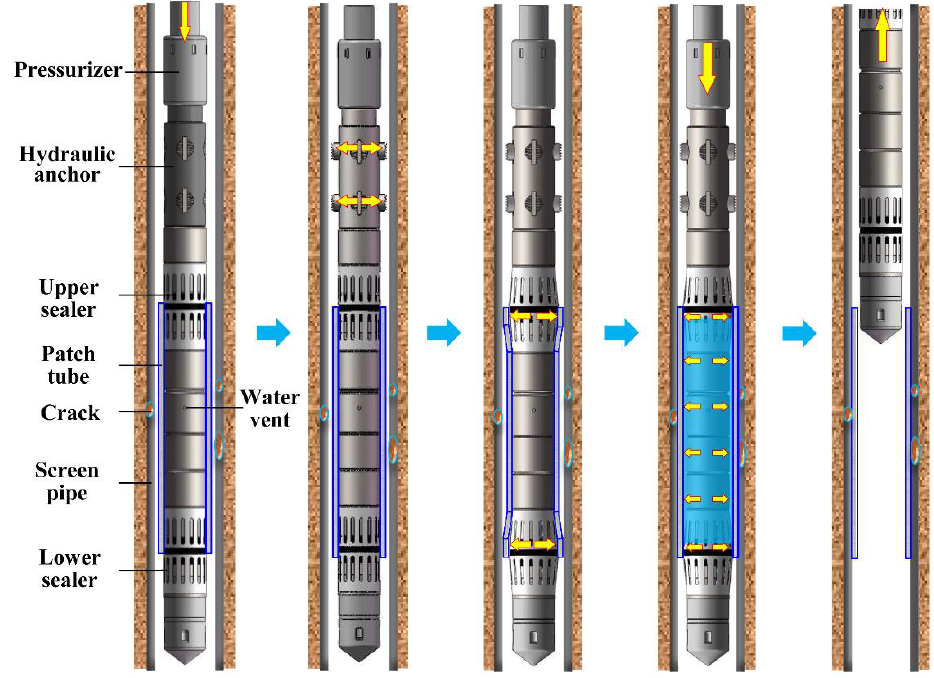
Figure 1. Structure of the patch